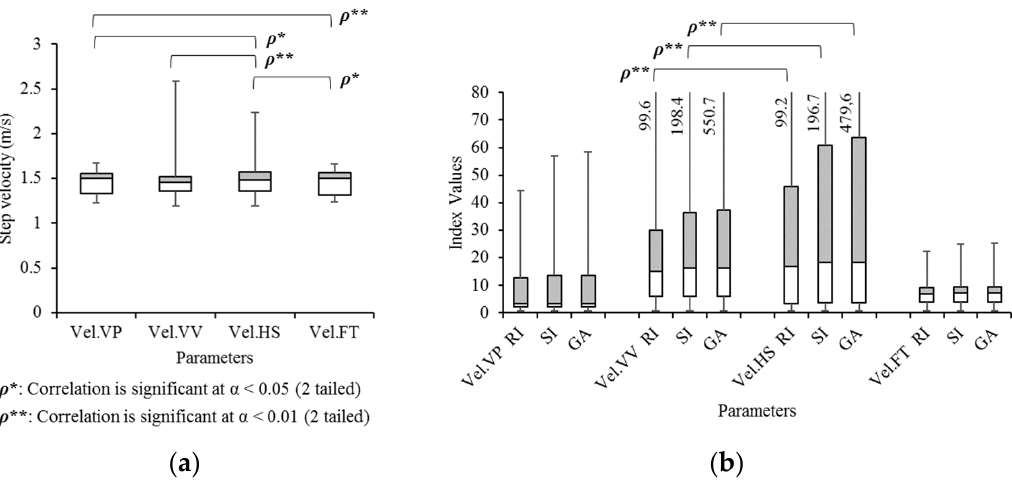
Figure 11. Box and Whisker diagrams of gait velocity (m/s) in ( a ) the average and ( b ) gait symmetry index values in four different measurement methods.